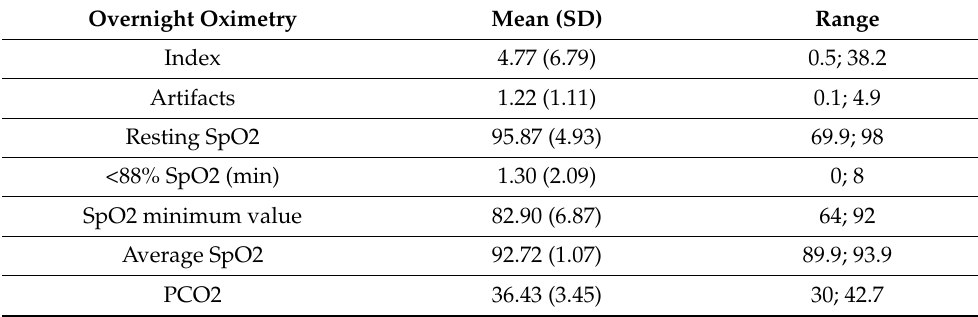
Table 3. Overnight pulse oximetry and capillary PCO2 readings.